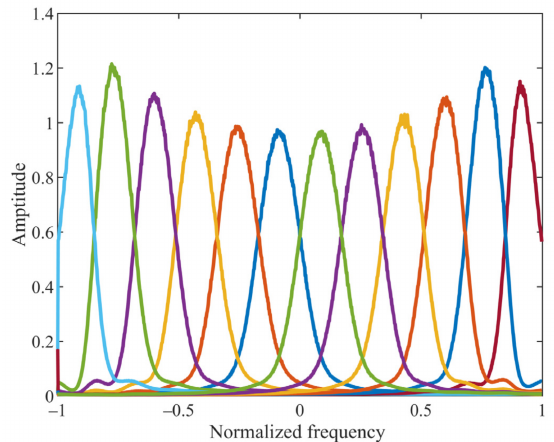
Figure 3. MCVMD equivalent filter